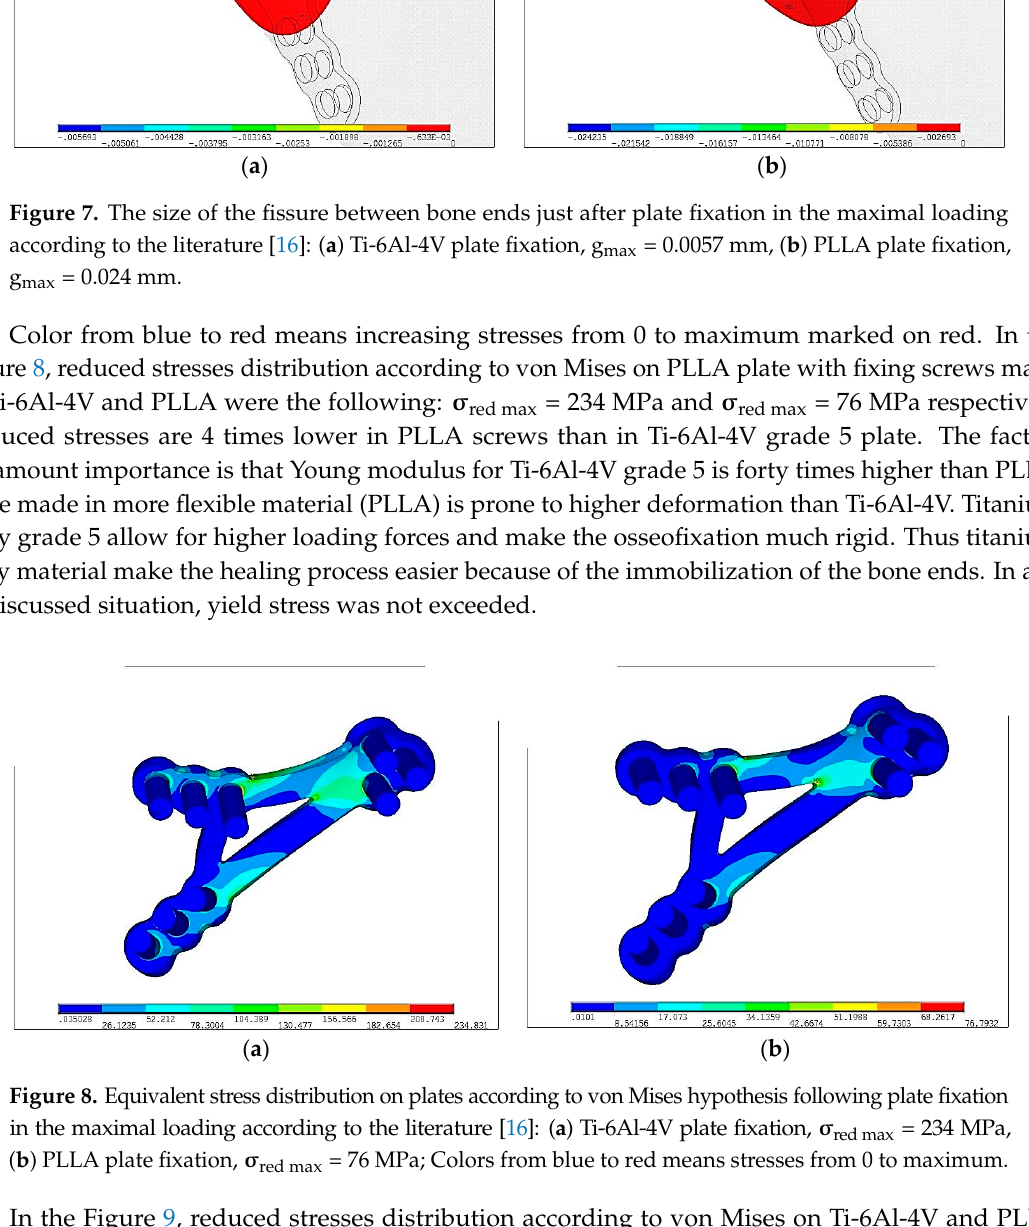
(b) Figure 9. Equivalent stress distribution in mandibular condyle according to von Mises hypothesis just after plate fixation in the maximal loading according to the literature [16]: ( a ) Ti-6Al-4V plate fixation, σ red max = 87MPa, ( b ) PLLa plate fixation, σ red max = 91MPa; Colors from blue to red means increasing stresses from 0 to maximum. Grey color on Figure 10 shows strain above the scale. Comparing 10(a) and 10(b) figures Ti-6Al- 4V plate and screws indicates the center of strains is around last screws in lower part of mandible. In PLLA plate the highest stress is around the hole that is located near the fracture. This location is at risk during surgical fixation because of secondary fractures during plate fixation that restricts possibility of PLLA usage.